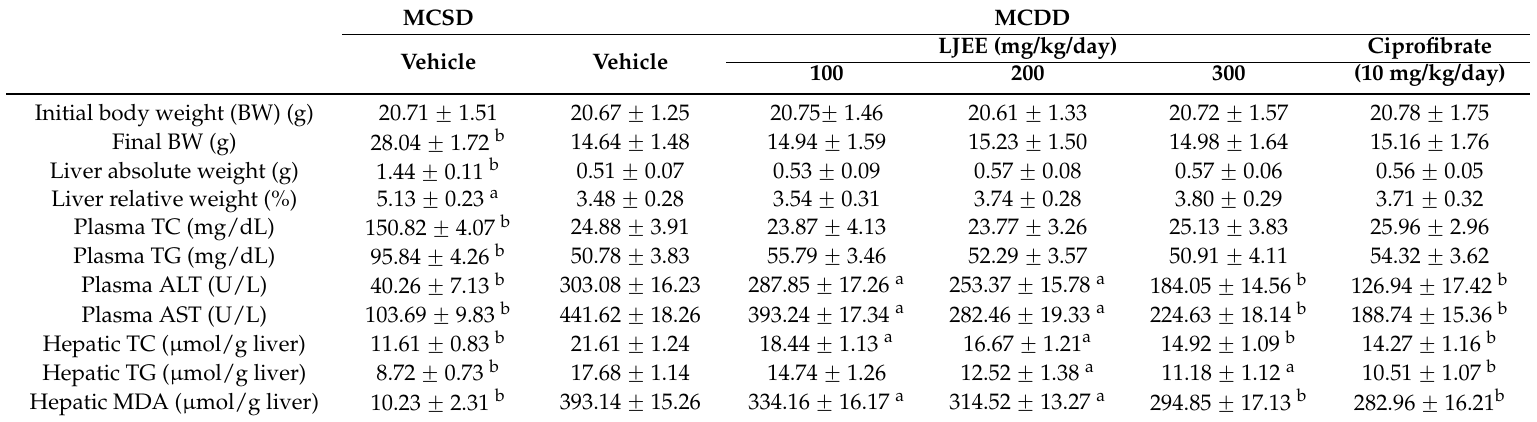
Table 2. Effects on blood biochemistry and hepatic parameters in MCSD- or MCDD-fed mice receiving four weeks of